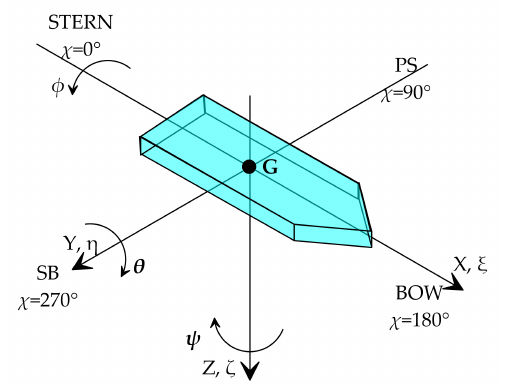
Figure 12. Reference system adopted for the seakeeping calculations.